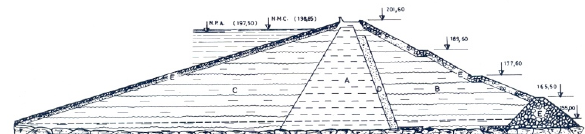
Figure 2. Embankment dam cross section (A – clay core; B;C – down- stream and upstream shoulders; D – chimney filter; E – rockfill). overflow spillways whose function is to prevent overtop- ping due to flooding that would lead to eventual